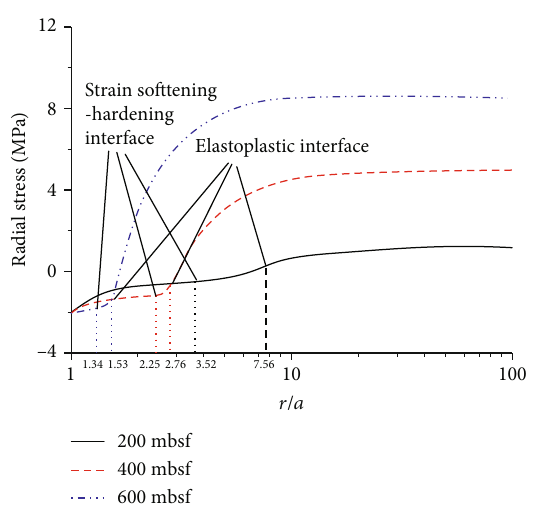
Figure 7: Relationship between radial stress and r / a at di ff erent / a at 0